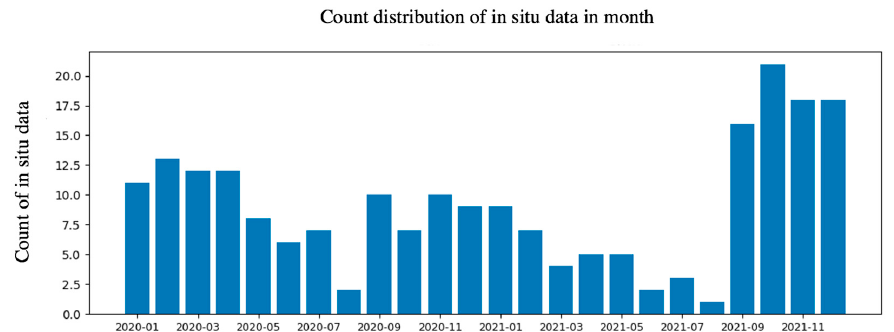
Figure 8. Data count distribution for the 156 in situ data samples.